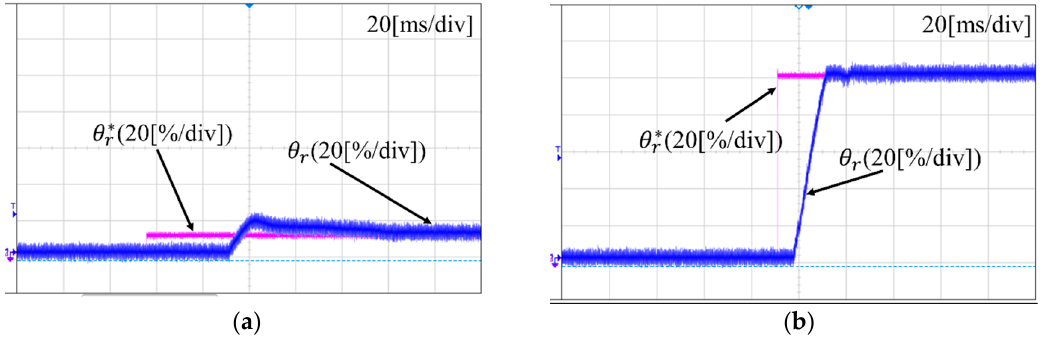
Figure 9. Position dynamic response when a ( a ) 10% and ( b ) 100% valve reference were applied.